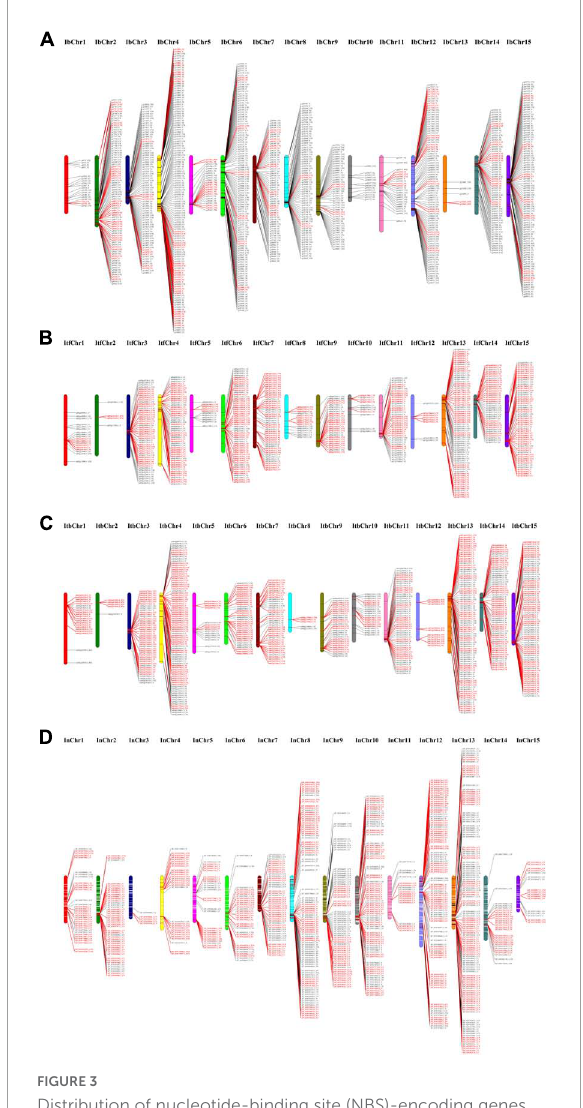
FIGURE3 Distribution of nucleotide-binding site (NBS)-encoding genes across chromosomes. (A) Distribution in sweet potato chromosomes. (B) Distribution in I. trifida chromosomes. (C) Distribution in I. triloba chromosomes. (D) Distribution in I. nil chromosomes. The red color indicates the tandemly duplicated NBS-encoding genes on the chromosomal